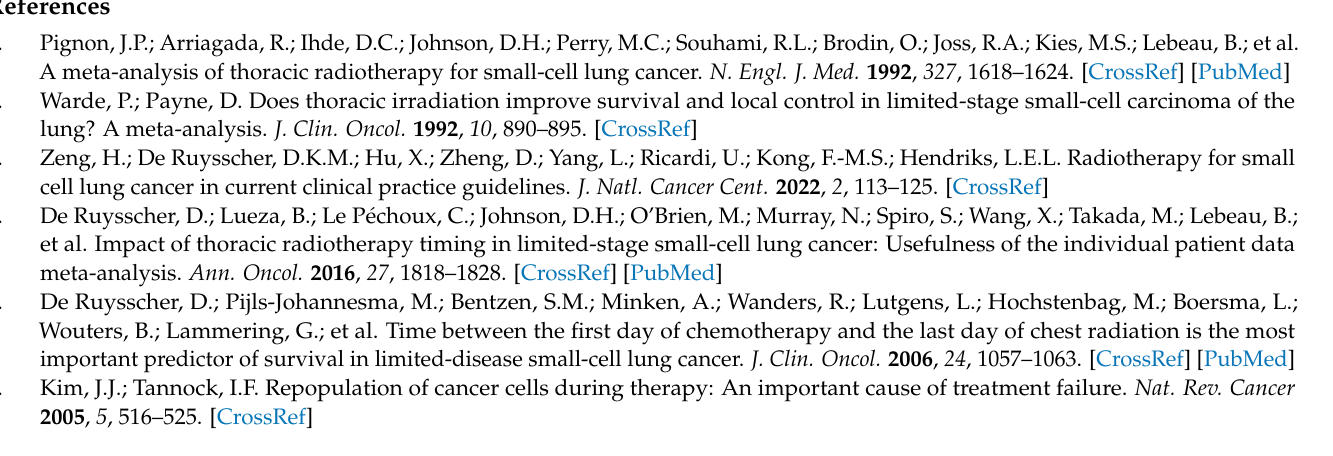
Table S6: Summary of the results from direct comparisons for overall survival; Table S7: Network meta-regression results; Table S8: Late severe radiation-related adverse events; Figure S1: Search strategy; Figure S2: Comparisons of the reconstructed and original curves; Figure S3: Network plots; Figure S4: Forest plots of severe radiation related events for altered fractionation modalities; Figure S5: Funnel plot according to the double arcsine transformed proportion for publication